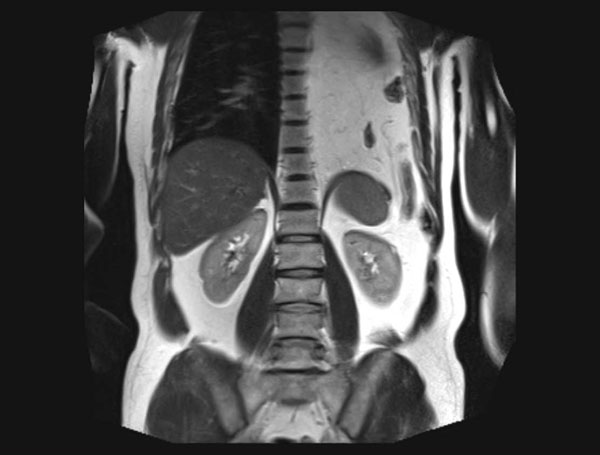
Pre-operative RMI